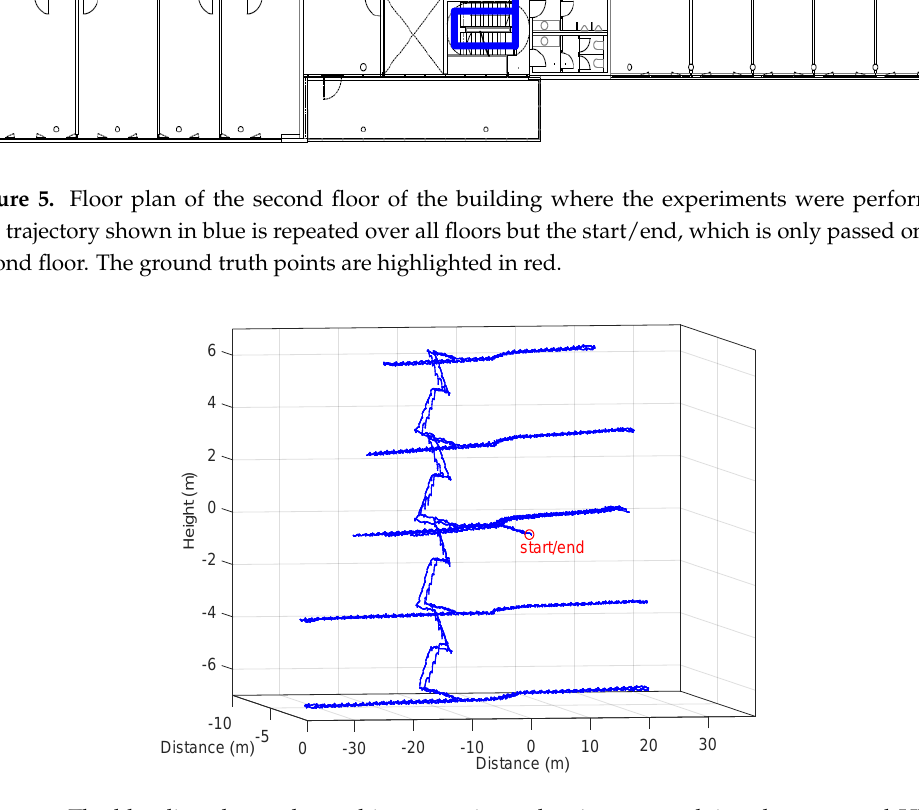
Figure 6. The blue line shows the multi-story estimated trajectory applying the proposed HUPT correction. A red circle highlights the start and ending